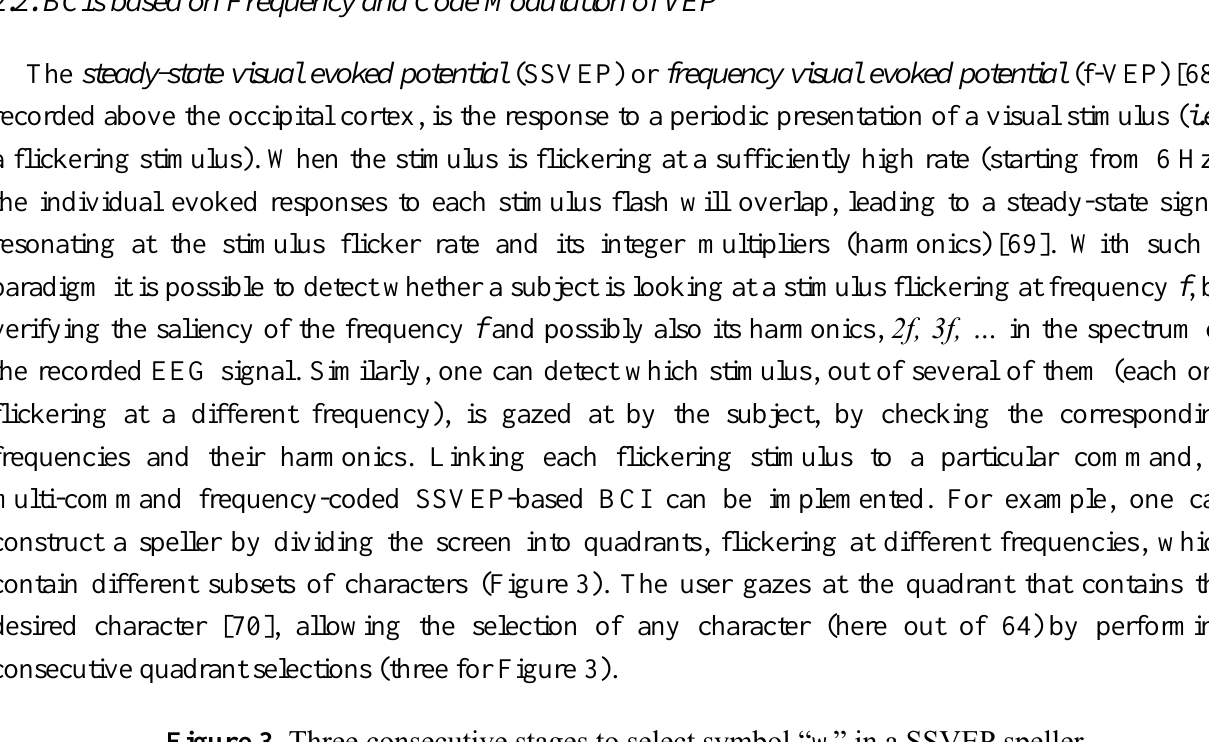
Figure 3. Three consecutive stages to select symbol ―w‖ in a SSVEP